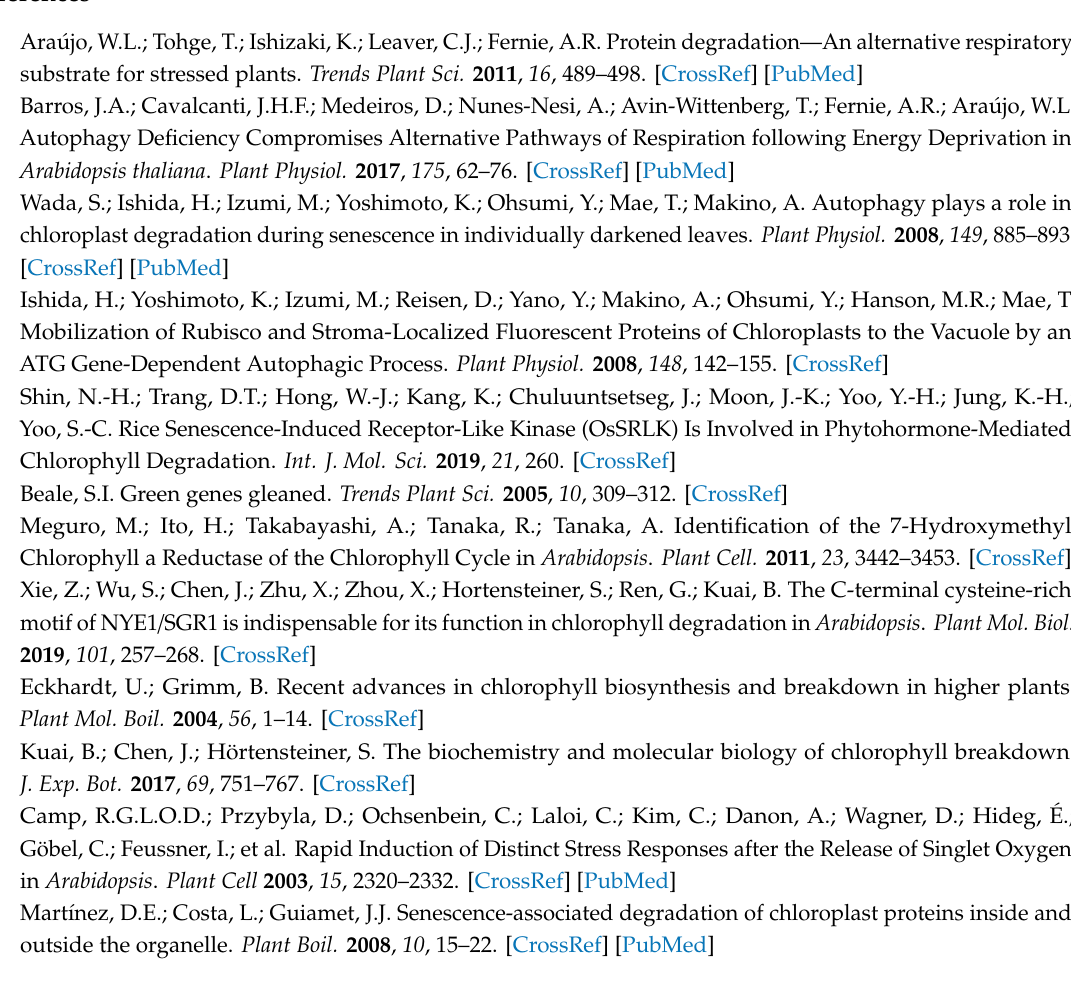
Table S1: Genes Located in the 118.6 kb deletion region ( n = 37), Table S2: Primers used in this